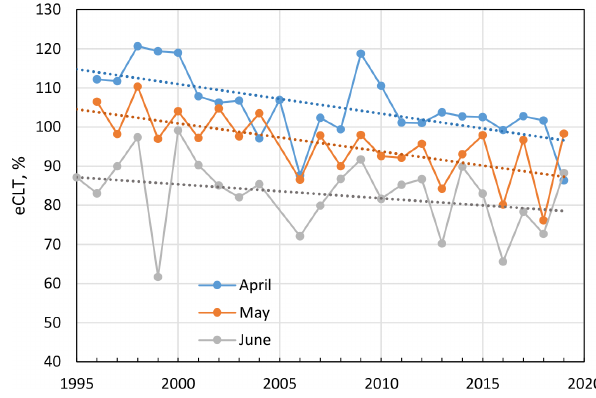
Figure 13. Monthly mean eCLT in Ny-Ålesund for April, May, and June 1995/1996 to 2019. Trends in eCLT are indicated as dotted lines.